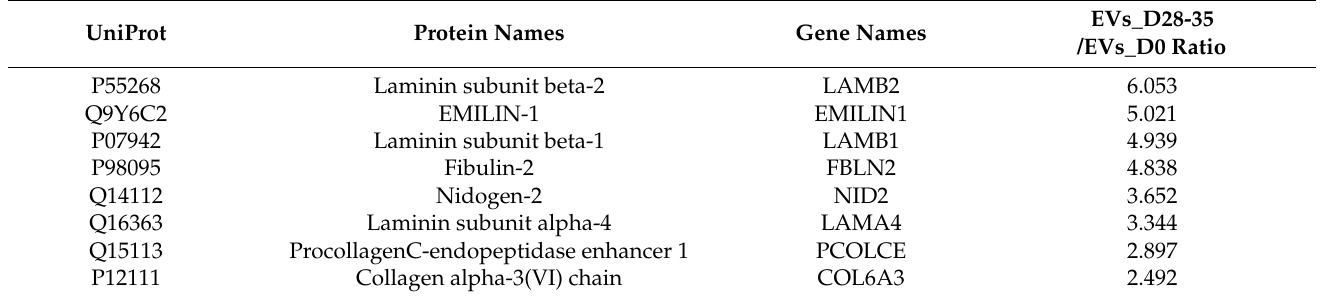
Table 4. The expression/level ratio of selected proteins involved in ECM remodeling in EVs_D28-35 compared with that in EVs_D0.